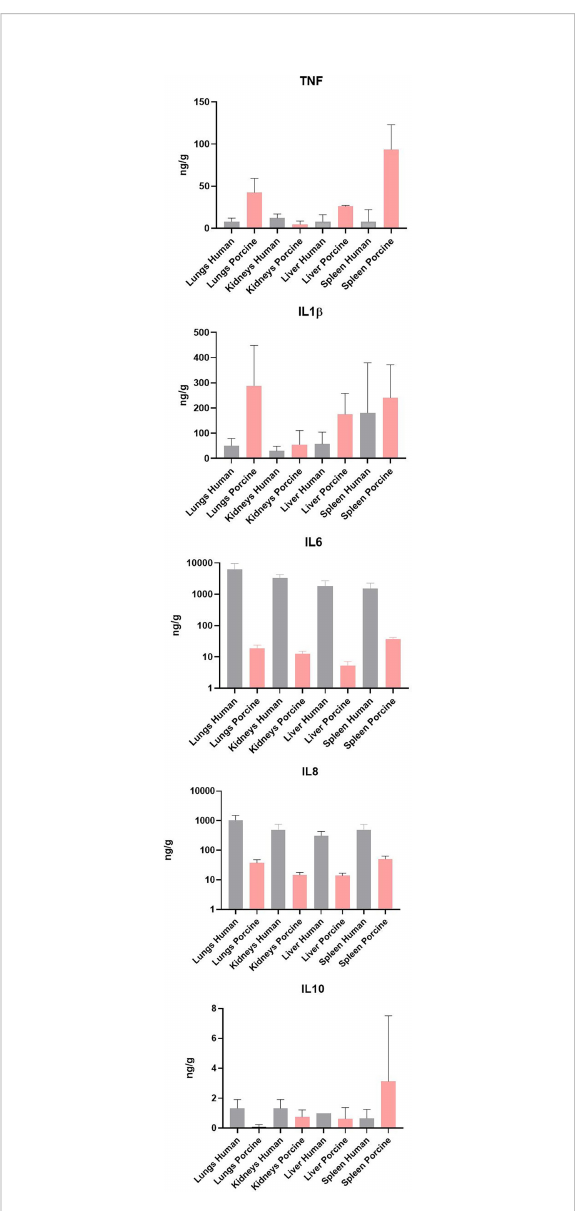
FIGURE 6 Cytokine concentration in fresh frozen tissue samples from patients with meningococcal septic shock ( n = 3) and in fresh frozen tissue samples from the experimental porcine model ( n = 8). The concentration unit is ng/g for the organ